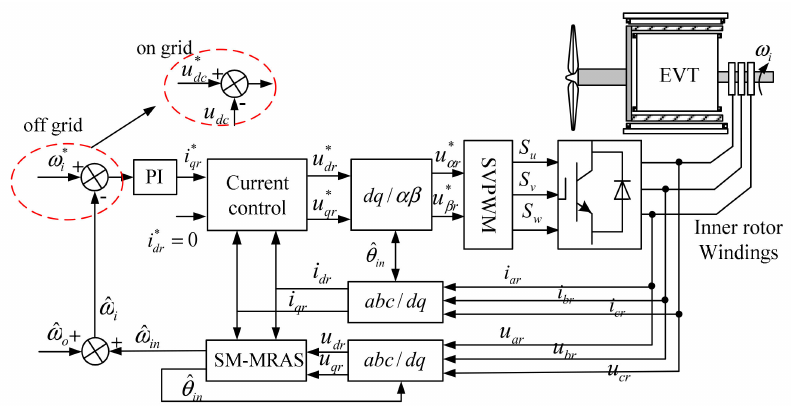
Figure 6. Control configuration of the inner rotor of the EVT.